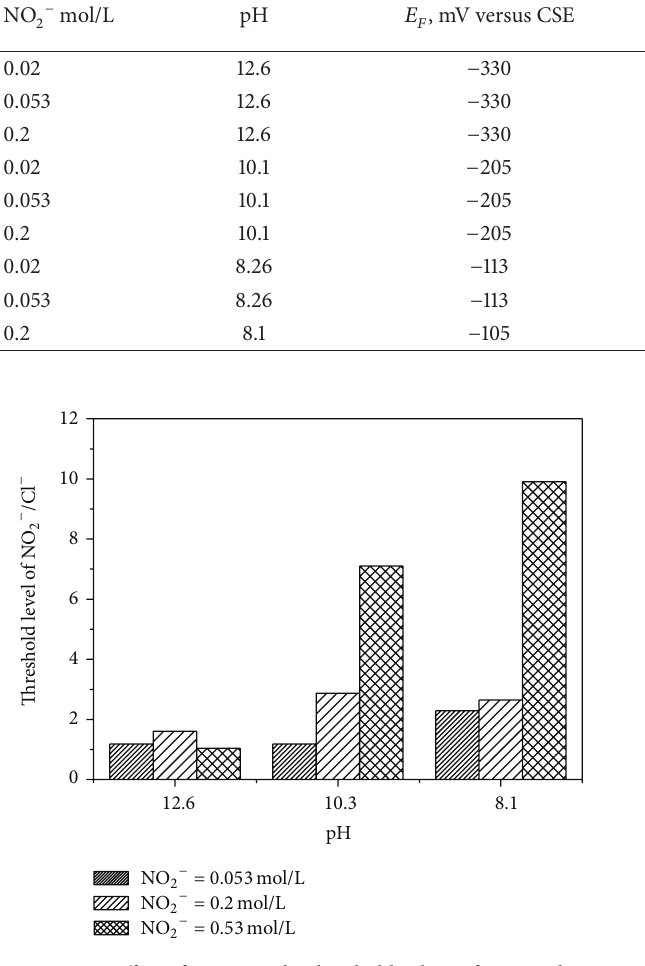
as the parameter to evaluate the inhibiting efficiency of nitrite on sulfate-induced corrosion.